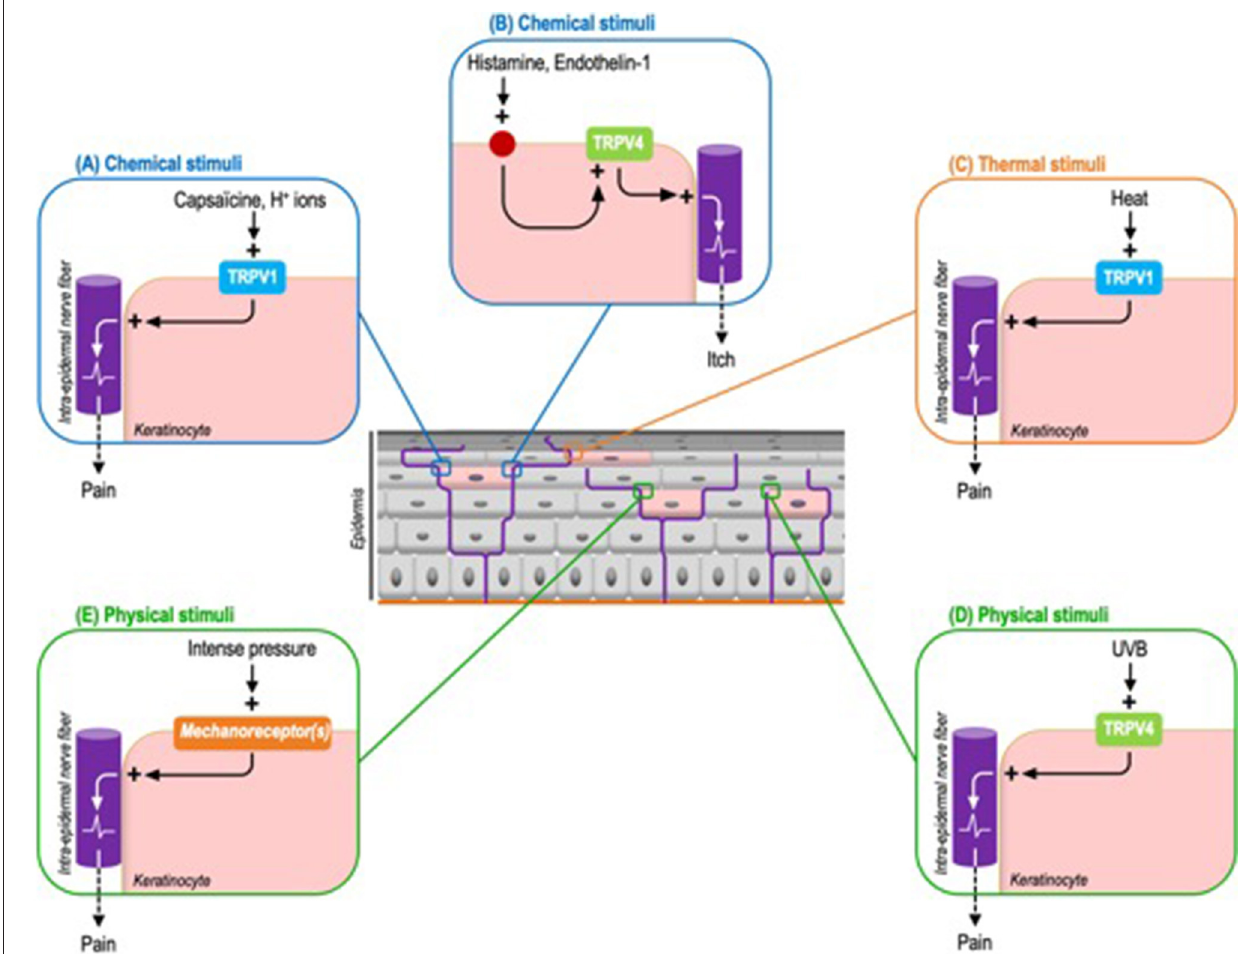
FIGURE 3 | Identified exogenous stimuli and the corresponding keratinocyte sensory receptors triggering pain or itch in mouse models. (A) Chemical stimuli. Capsaicin can induce pain through the activation of keratinocyte-expressed TRPV1. By extension this process probably concerns H + ions. (B) Chemical stimuli. Histamine and endothelin-1 activate TRPV4 through their respective receptors. Downstream TRPV4 activation induces itch. (C) Thermal stimuli. TRPV1 is also the main transducer of noxious heat. (D) Physical stimuli. UVB activate keratinocyte-expressed TRPV4 to induce pain. (E) Like intense pressure via not yet identified